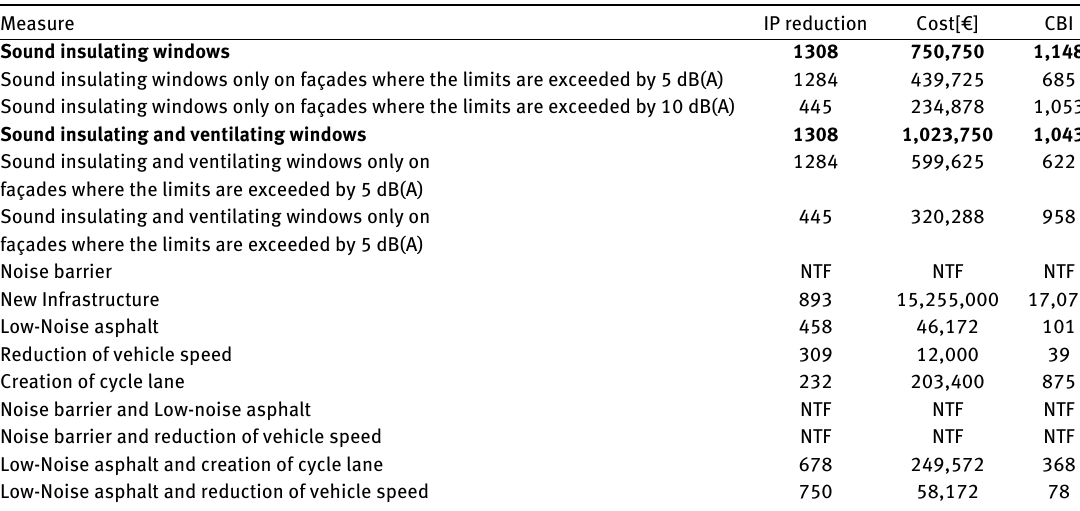
Table 7: Example of CBI evaluation for a critical area. Measures allowing to solve the noise exposure are highlighted in bold. NTF stands for measure not technically